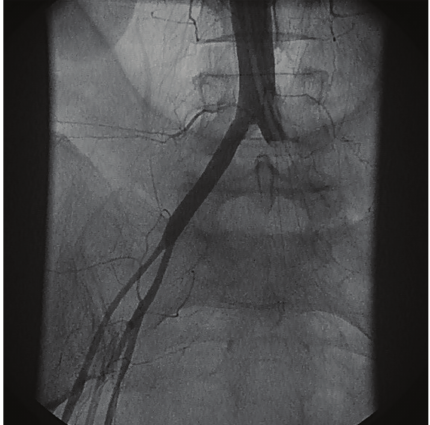
Figure 3: Angiogram showing complete occlusion of the left common iliac artery with no distal flow and collapsed right external iliac systems consistent with hypotension.